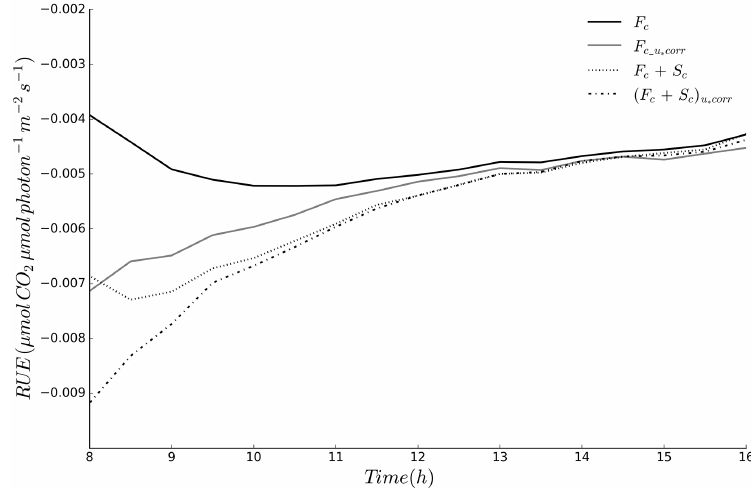
Figure 15. Effects of addition of storage term and application of daytime u ∗ filtering on radiation use efficiency (RUE).